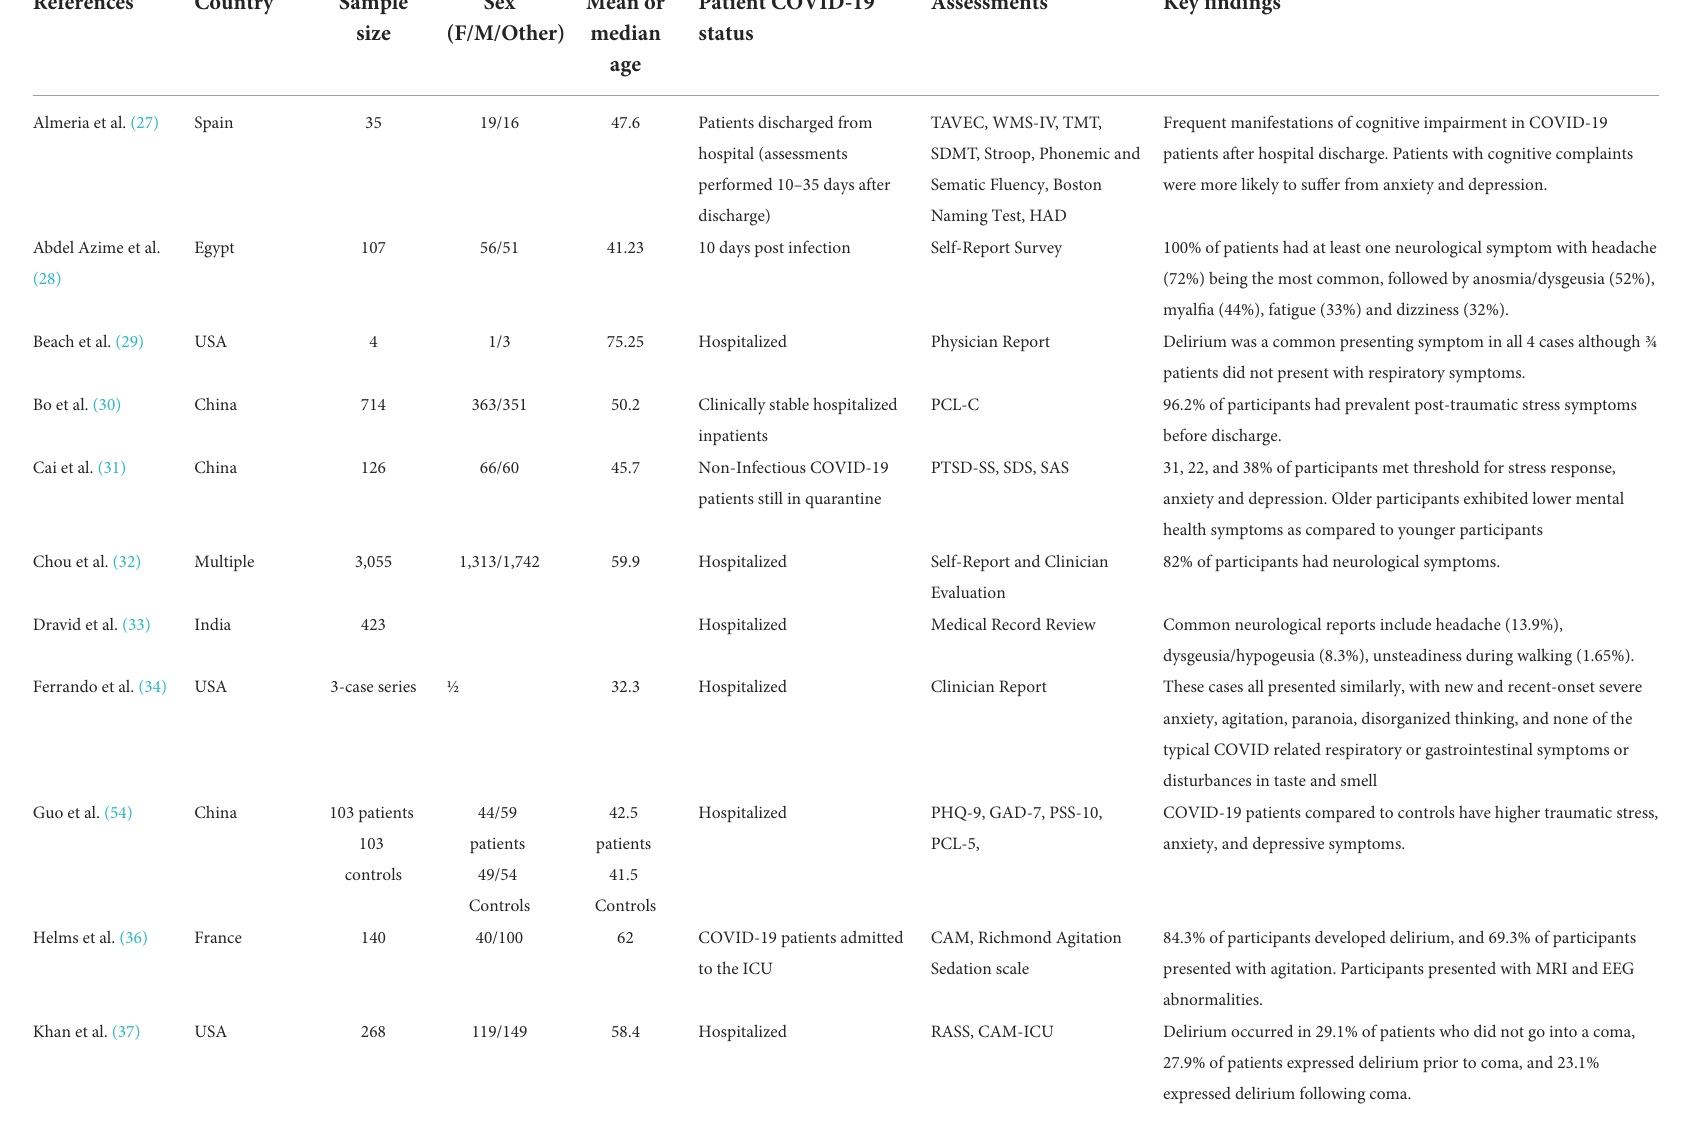
TABLE 1 Studies investigating acute neuropsychiatric